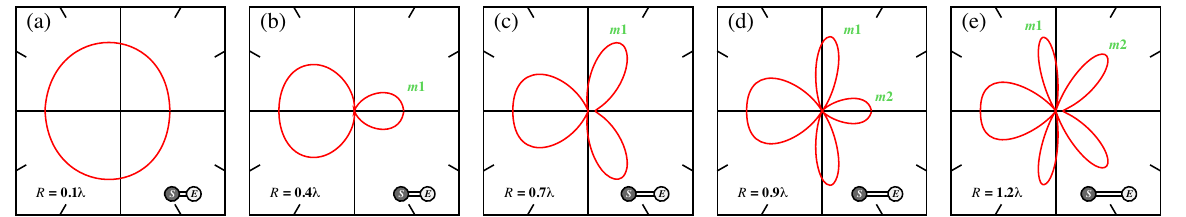
FIG. 5. Examples of diffraction patterns in polar representation. A wave with wavelength λ is emitted from the right center (emitter, labeled “ E ” ) and diffracted at the left center (scatterer, labeled “ S ” ). The red line depicts the angular distribution of the superposition of the direct and the scattered wave. (a) to (e) show the angular distributions for different distances between E and S . (a) At shortest distances no diffraction lobes are visible. (b) As the distance increases, a first maximum m 1 forms toward the emitter side. (c) Further increase yields the first minimum in the direction of E and the maximum m 1 moves toward the main lobe in the direction of S . As the distance is increased, a new lobe m 2 appears (d) and moves toward S , as well (e).